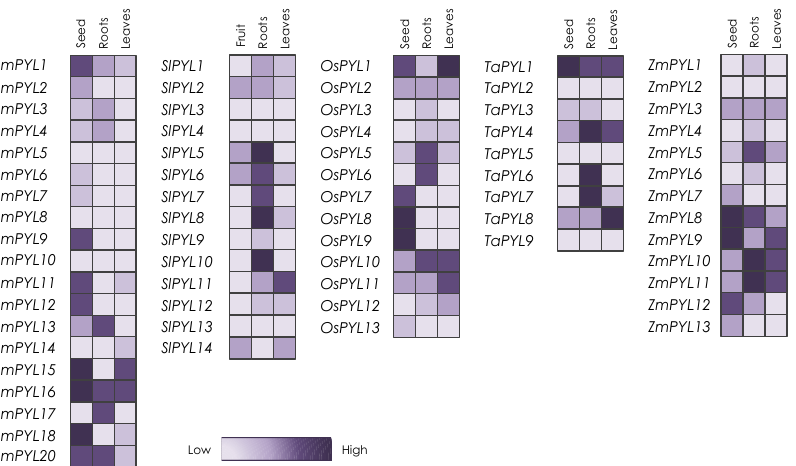
Figure 2. Gene expression of the ABA receptors in different crops. The expression levels of the different genes are represented with increasing purple intensities as indicated in the legend. Expression data were extracted from the references indicated in the text [39,41,42,45,46,49,74].